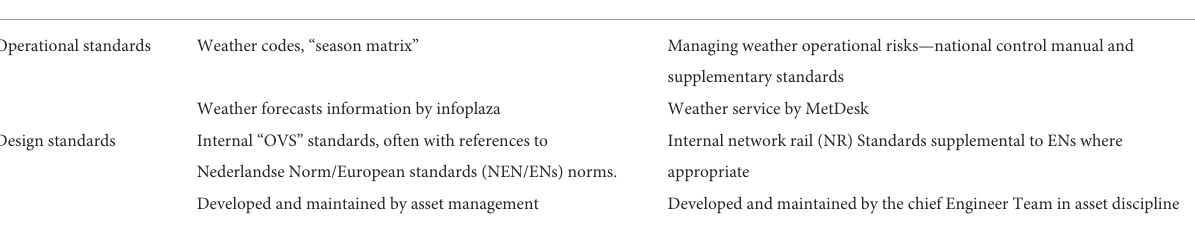
TABLE 3 Use of climate information in standards. Standards